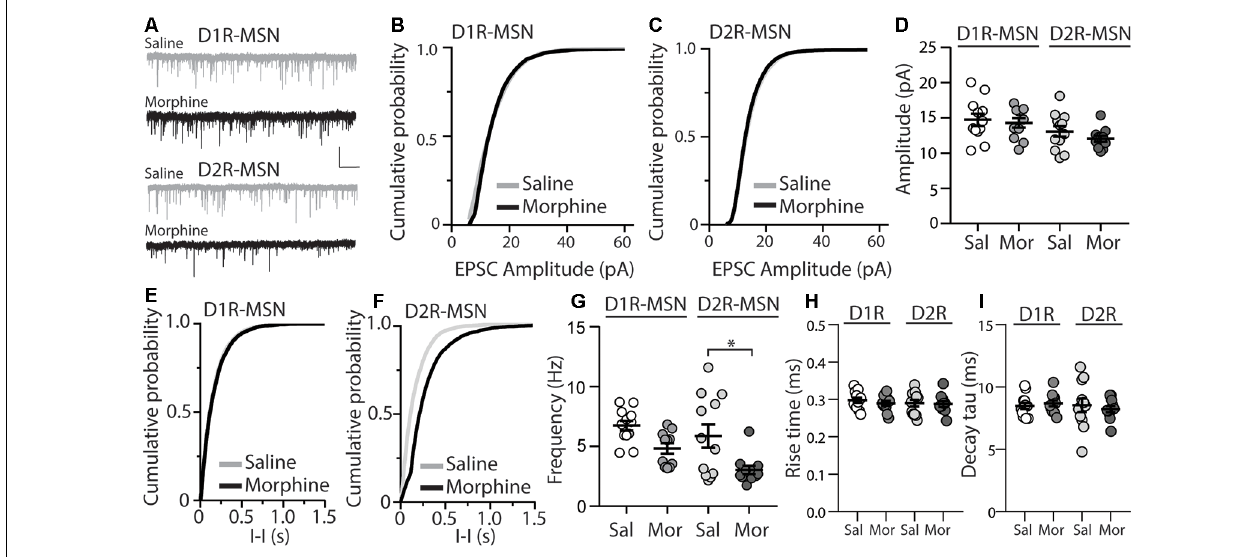
FIGURE 1 | Repeated morphine administration reduces miniature excitatory postsynaptic current (mEPSC) frequency on dopamine D2-receptor medium spiny neurons (D2R-MSNs) on abstinence day 1. (A) Representative traces showing mEPSCs recorded from D1R- or D2R-MSNs from animals treated with saline or morphine (10 mg/kg, i.p.). Scale bar: 20 pA, 1 s. (B,C) Cumulative plot of a representative neuron showing the distribution of mEPSC amplitudes recorded from D1R-MSNs (B) or D2R-MSNs (C) in animals treated with saline or morphine. (D) Summary graph showing the average mEPSC amplitude recorded D1R- or D2R-MSNs following saline or morphine treatment ( F ( 3,42 ) = 2.92, p = 0.045; One-way ANOVA. Bonferroni post-test, D1R-MSN: saline vs. morphine, p > 0.999; D2R-MSN: saline vs. morphine, p > 0.999). (E,F) Cumulative plot of a representative neuron showing the distribution of mEPSC inter-event intervals (I-I)